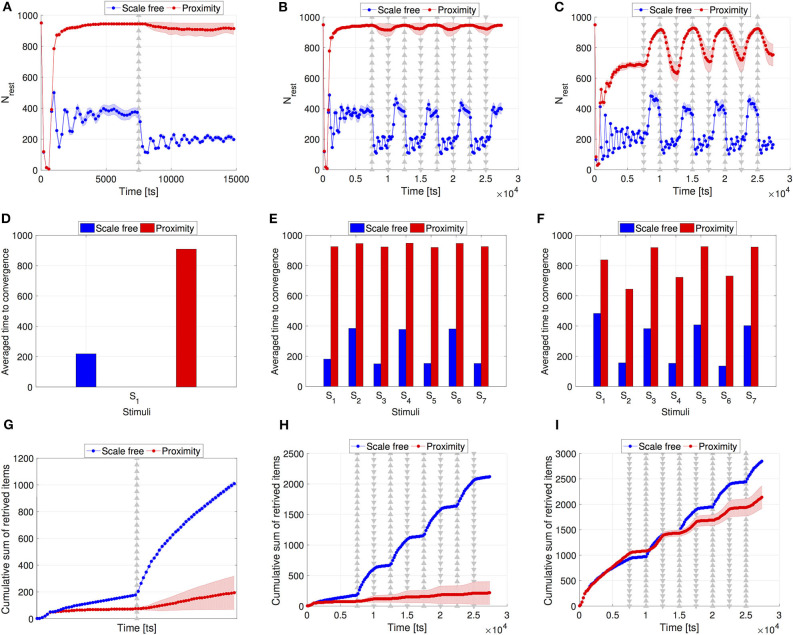
Swarm performance comparison between the scale-free networks (blue) and the proximity networks (red). (Top) Swarm collective response in terms of Nrest. (A) Single stimulus of item gain from Nitems = 30 to Nitems = 300 at tcrit = 7, 500 ts, and (B) multiple stimuli are executed in intervals of Δtcrit = 2, 500 ts. The items are repeatedly increased to Nitems = 300 (indicated by ▵) or reduced to Nitems = 30 (indicated by ▿). (C) Similar setting to (B), but starting from Nitems = 300 and changing the items in an inverse order, as indicated by the ▵ and ▿ markers. (Center) Swarm convergence time. (D) Single stimulus of item gain, S1 is the index for the stimulus applied at tcrit = 7, 500. (E) Multiple stimuli where items are repeatedly increased or reduced. S1…7 correspond to the seven stimuli applied between tcrit = 7500 ts and t = 25, 000 ts in intervals of Δtcrit = 2, 500 ts, as in (B). (F) Similar to (E) but with an inverse order, as in (C). (Bottom) Cumulative sum of the retrieved items. (G) Scenario with a single stimulus. (H) Scenario that starts with Nitems = 30, as in (B). (I) Scenario that starts with Nitems = 300, as in (C). In (A–C) and in (G–I), shaded areas indicate the confidence interval of 95%. All results were averaged over 30 runs.